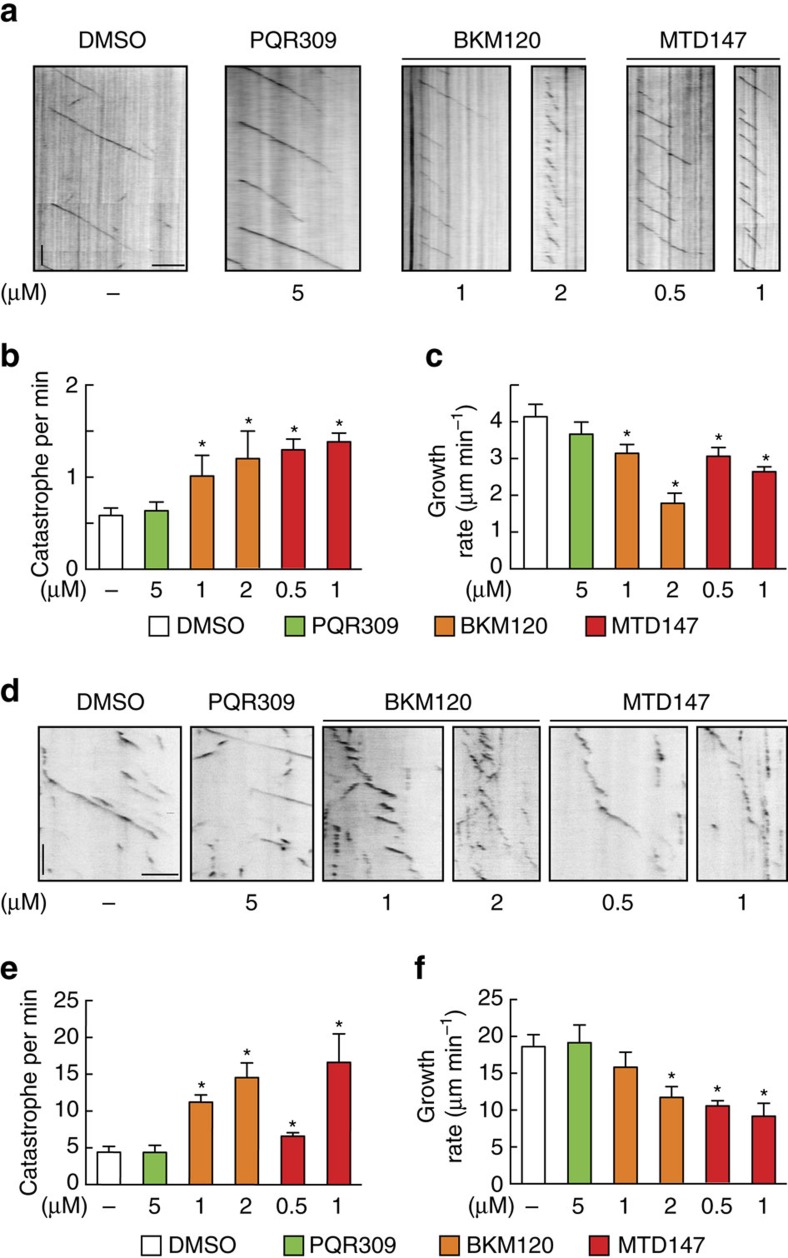
Drug-dependent changes in microtubule dynamics.(a) Representative kymographs depicting in vitro microtubule dynamics determined in the presence of the microtubule plus end tracking protein GFP-EB3 and the indicated drugs. To save space, kymographs were truncated horizontally to the longest microtubule traces. Time bar (vertical, 60 s) and distance bar (horizontal, 3 μm) apply to all images. (b) Quantification of the in vitro microtubule catastrophe frequency derived from experiments as exemplified in a in the absence or presence of indicated drugs (mean±s.d., DMSO n=5, compounds n=3, *P=0.036, Mann–Whitney test). (c) Quantification of microtubule growth rates in vitro (mean±s.d., DMSO n=5, compounds n=3, *P=0.036, Mann–Whitney test). (d–f) Microtubule dynamics were monitored in HeLa cells stably expressing plus-end binding EB3-GFP in the presence of PQR309, BKM120 and MTD147 using live cell microscopy and are illustrated as kymographs. Time bar (vertical, 20 s) and distance bar (horizontal, 3 μm) apply to all images. (e) Quantification of cellular microtubule catastrophe frequencies (mean±s.d. DMSO n=5, PQR309 n=4, BKM120 and MTD147 n=3; *P=0.0238, Mann–Whitney test) in the presence of indicated drugs. (f) Quantification of drug effects on cellular microtubule growth rates (mean±s.d., DMSO n=5, PQR309 n=4, BKM120 and MTD147 n=3; *P=0.0238, Mann–Whitney test).